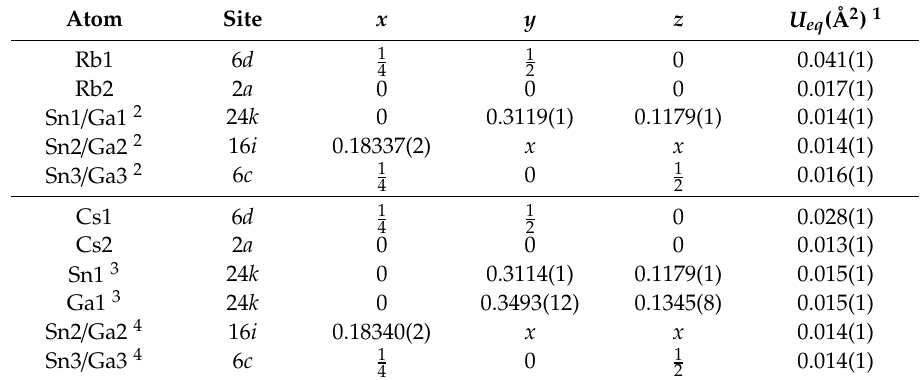
Table 2. Fractional atomic coordinates and equivalent isotropic displacement parameters U eq (Å 2 ) 1 for